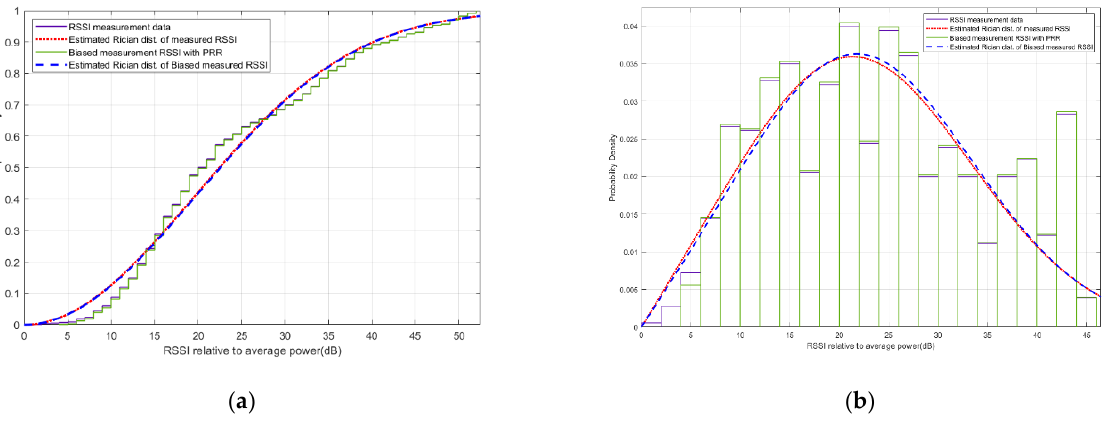
Figure 8. ( a ) CDF and ( b ) PDF of conventional and biased Wi-SUN channel approximation (2FSK-433-100 alias).